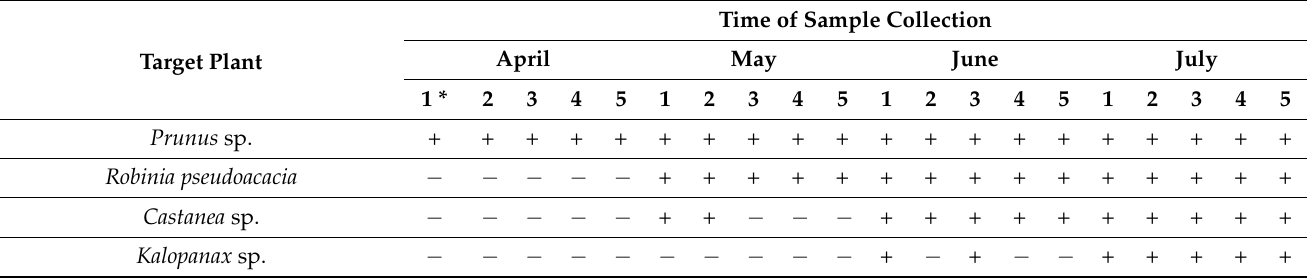
Table 3. Detection of the seasonal nectar plants from the honey samples.